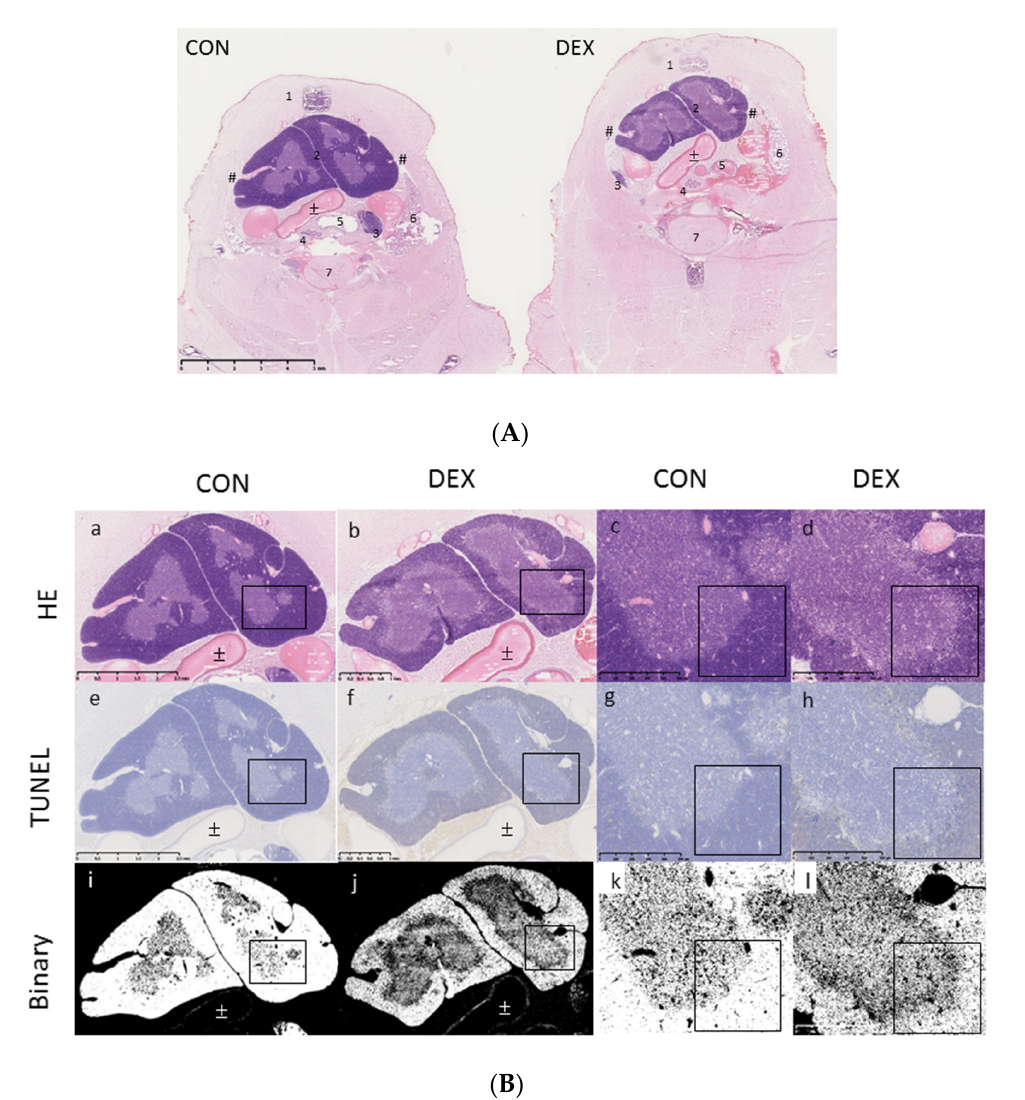
Figure 2. Microscopic image of the murine thorax before and after DEX administration. ( A ) HE-stained thoracic tissue sections after IMS. Left: Control; Right: DEX administered ICR mouse. 1. Bone marrow, 2. Thymus, 3. Lymph node, 4. Esophagus, 5. Trachea, 6. Lung, 7. Spinal cord. ( B ) HE ( a , b ) and TUNEL ( e , f ) staining of the thoracic sections. The binary images of HE staining were also shown in ( i , j ). Scale bar; 2.5 mm ( a , e ); 1 mm ( b , f ); 500 µ m ( c , d , g , h ). ( c , d , g , h , k , l ) were the enlarged figure of the squared area from ( a , b , e , f , i , j ), respectively. ± shows aortic arch.